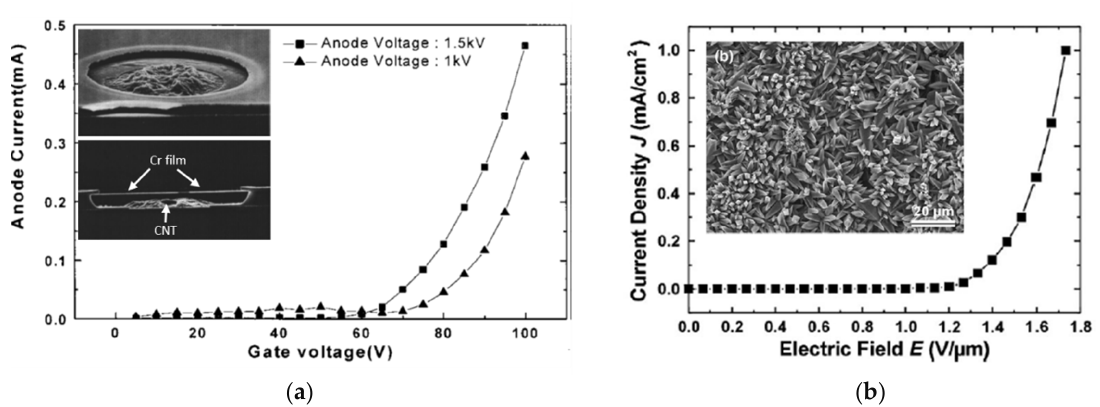
Figure 10. I–V characteristics of the CNT FED in a triode configuration. The insets show SEM images of a single FE cathode in a triode configuration. Figure 10a reprinted with permission from [65] and Figure 10b reprinted with permission from [120].